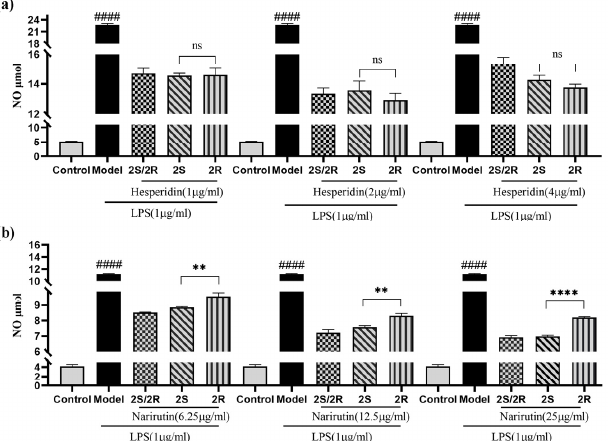
Figure 4. Effects of hesperidin and narirutin epimers on LPS-induced NO production in macrophage cells. ( a ) Effect of hesperidin isomers on LPS-induced NO production in LPS-stimulated RAW 264.7 macrophages. ( b ) Effect of narirutin isomers on LPS-induced NO production in LPS-stimulated RAW 264.7 macrophages. All data are presented as the means ± SEM of three independent experi- ments. #### p < 0.0001 vs. Control group. ** p < 0.01 and **** p < 0.001 vs. S-epimer group. ns not statistically